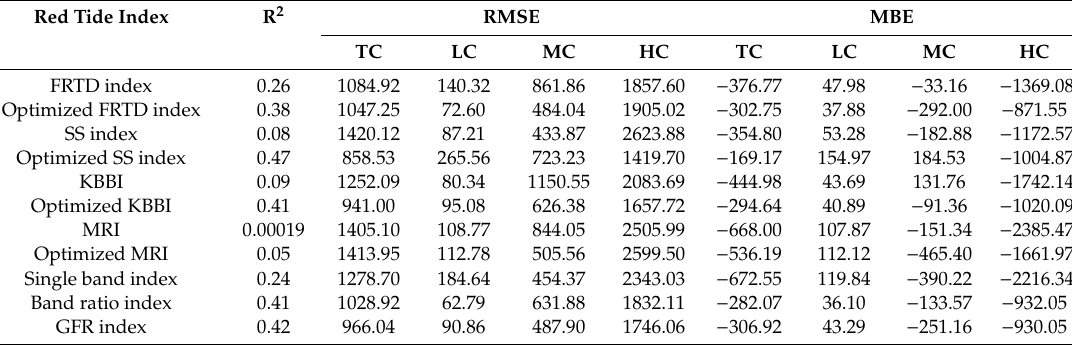
Table 4. Performance of one proposed and four published red tide indexes. TC indicates the total cell abundance group (all samples). HC (high cell abundance), MC (middle cell abundance), and LC